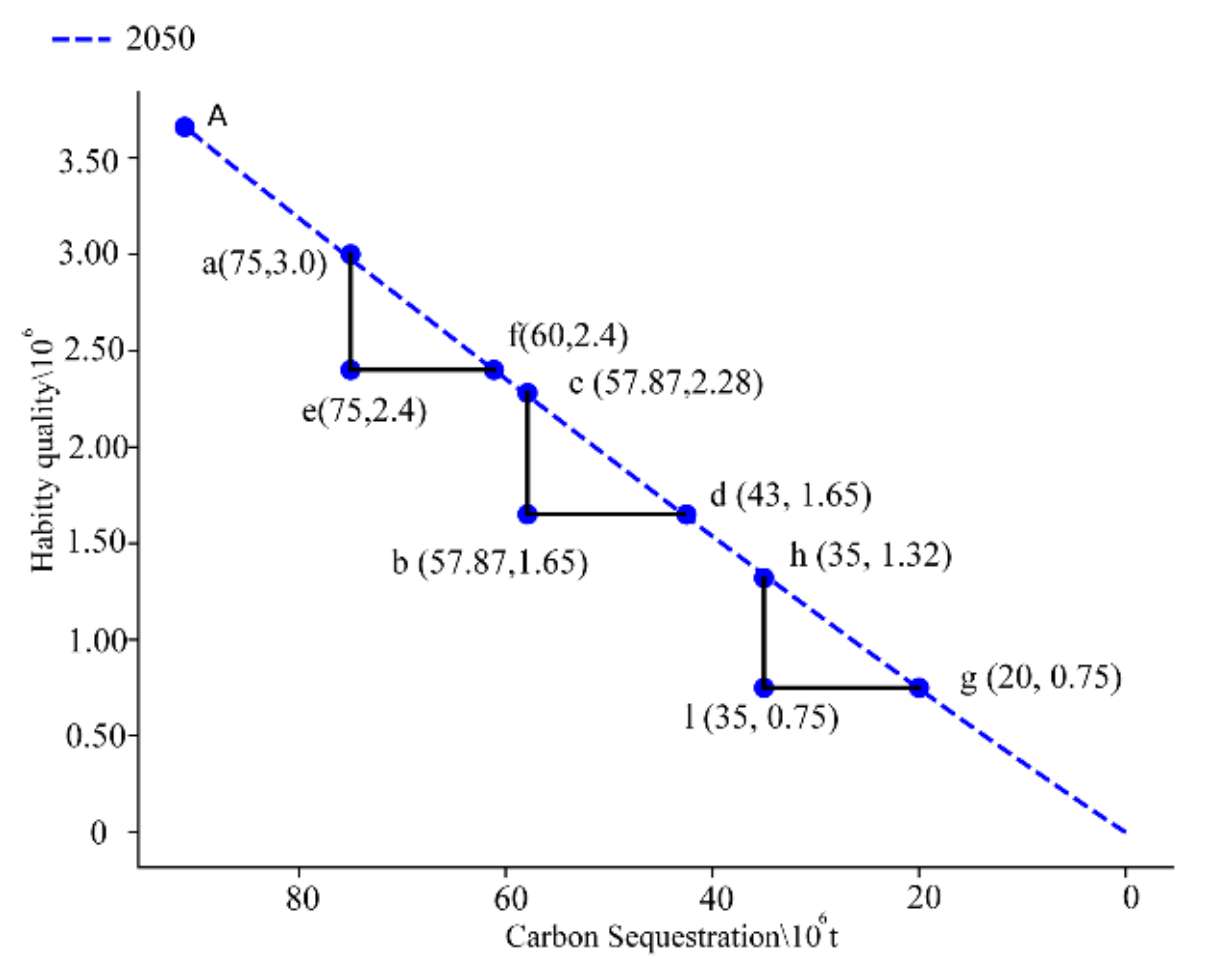
Figure 5. PPF curve between habitat quality and carbon sequestration.